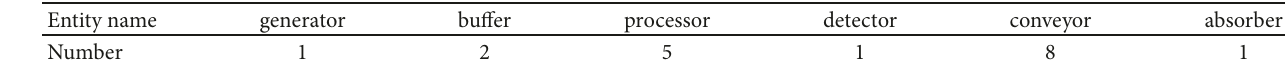
Table 1: Number and name of model